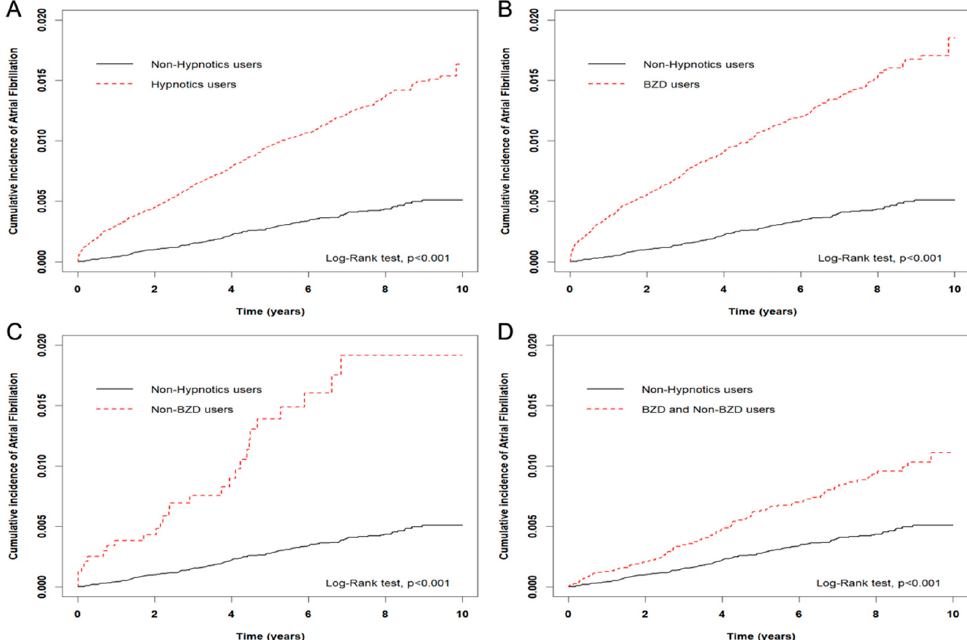
Figure 1. Comparisons of Kaplan–Meier estimates for the cumulative incidence rate of atrial fibrillation between hypnotic and non-hypnotic cohorts. Using the log-rank test, the cumulative incidence rates of atrial fibrillation (AF) were higher in participants with prescribed use of either or both of benzodiazepines (BZDs) and non-BZDs ( A ), isolated BZDs ( B ), isolated non-BZDs ( C ), and their combinations without priorities ( D ) than those with no prescription of hypnotics ( P <0.001, respectively).